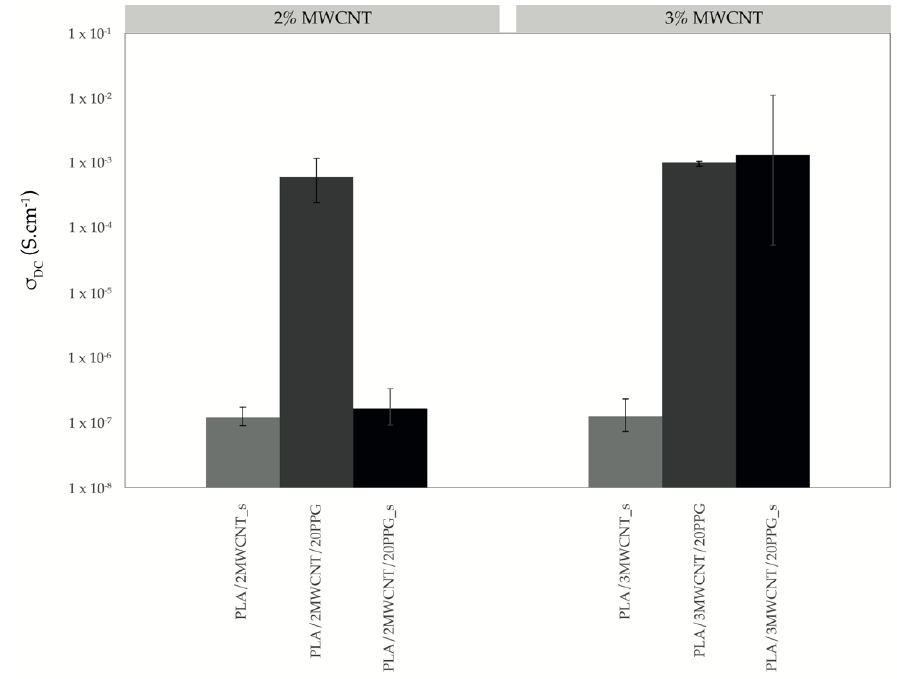
Figure 9. Direct current (DC) conductivities of composite filaments. Error bars denote maximum and minimum σ DC .